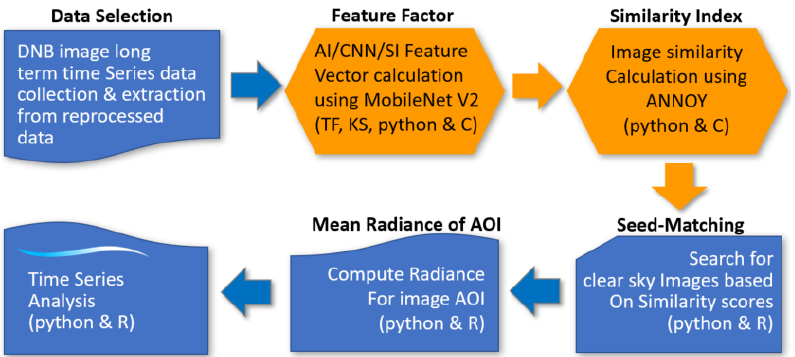
Figure 1. Algorithm Flowchart for Urban Night Light Long-Term Time Series Analysis (blue = developed by the authors; orange = adopted and integrated).